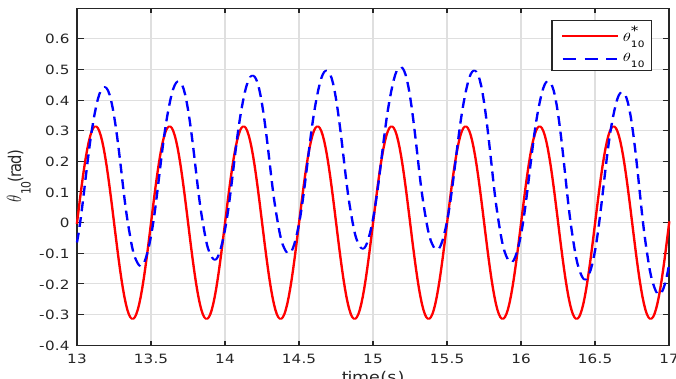
Figure 14. The angle of the first joint in Karman vortex.